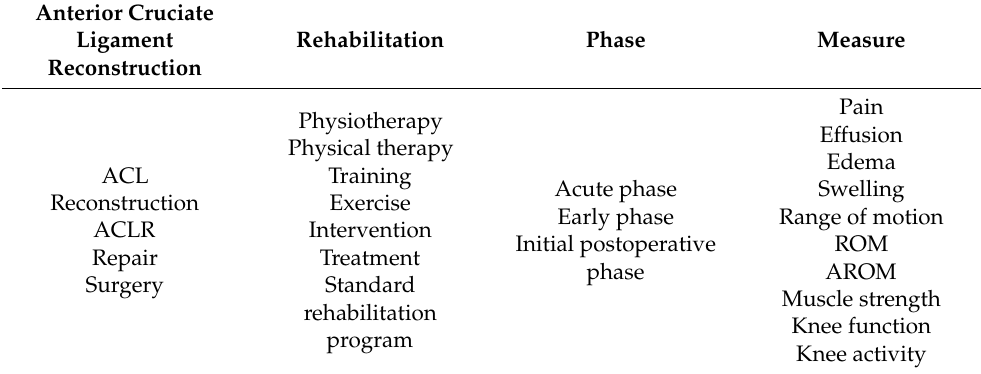
Table 1. Keyword sets used in the database